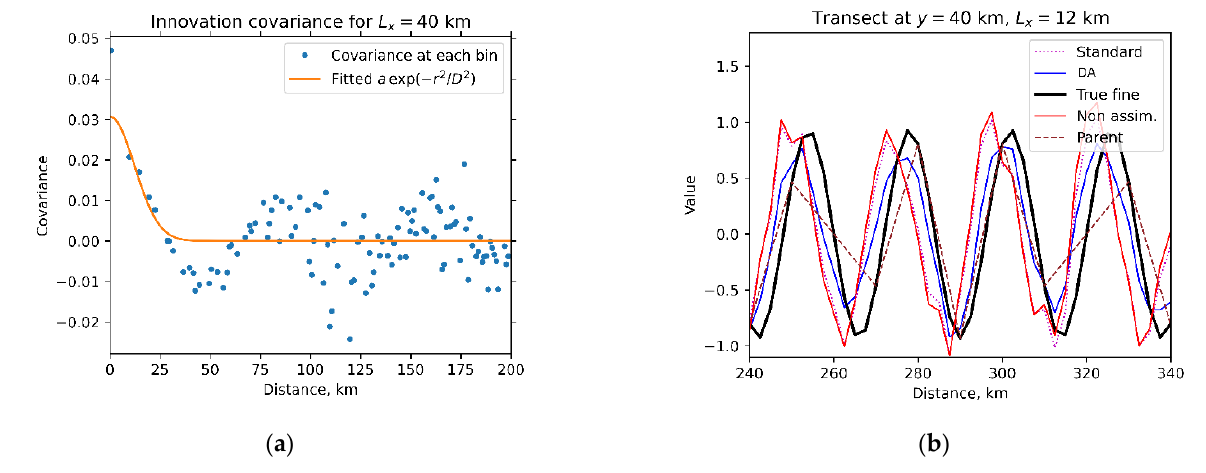
Figure 17. ( a ) Estimates of background and observational error covariances for multiple eddy field with L x = 40 km and L y = 105 km and the corresponding fitting curves. The error variances estimated at r = 0 are used as diagonal elements of the background matrix B (equal to 0.031) and the ‘observational’ matrix R (equal to 0.016); ( b ) the zonal transect at y = 40 km showing the true field (black line), parent model (dashed brown), child model noisy forecast before DA (red), analysis state after ’standard’ DA (dotted magenta), and analysis after NDA (blue).